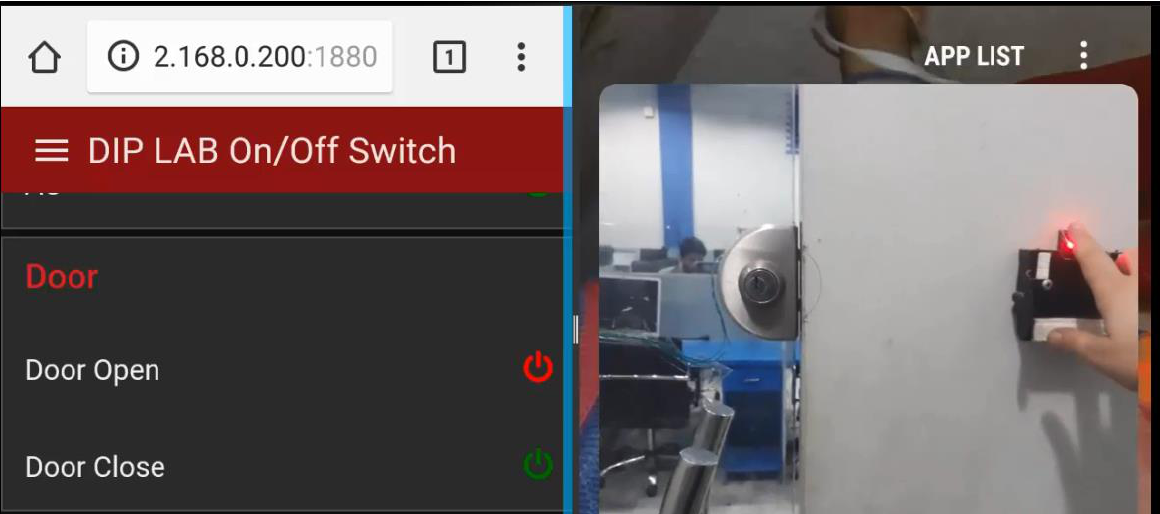
Figure 10. The door status using a Fingerprint-based authentication system.